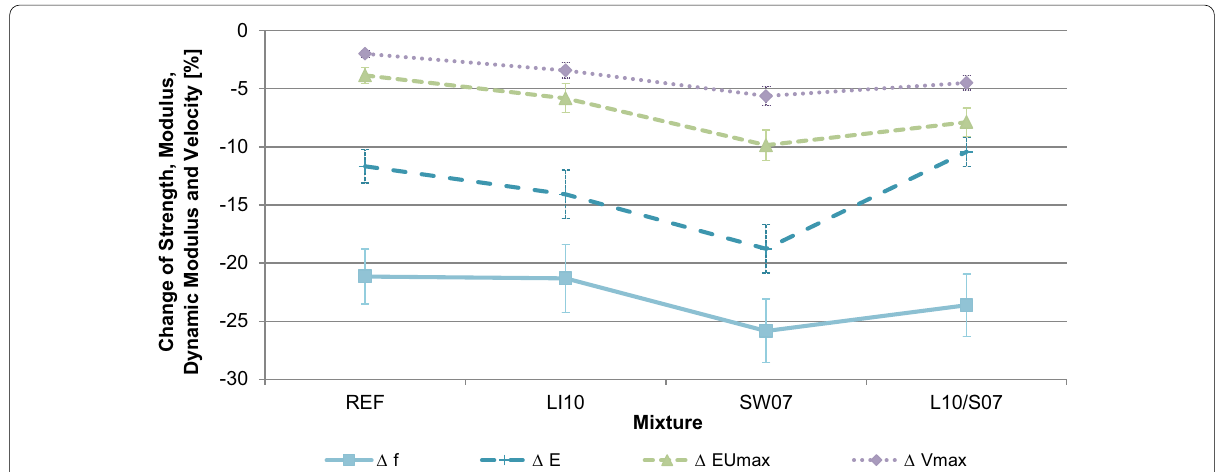
Fig. 18 Changes of parameters from measurement of ultrasonic pulse method and mechanical characteristics in cement-bonded particleboards during exposition to conditions in accordance with EN